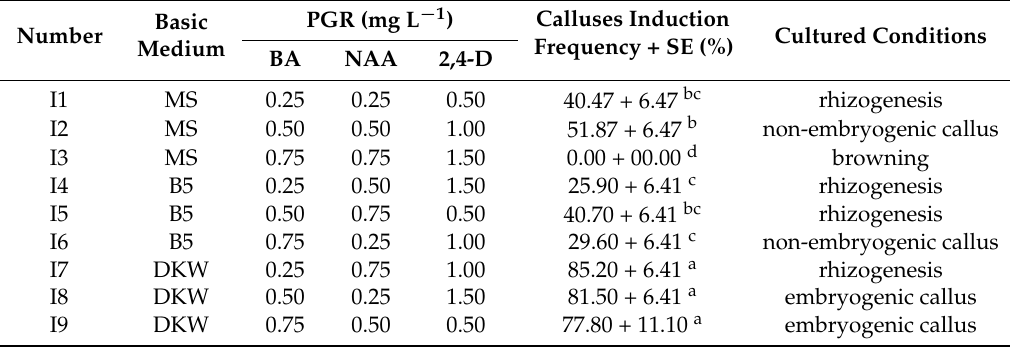
Table 1. Effects of medium types and plant growth regulator (PGR) concentrations on callus induction in K. paniculata .